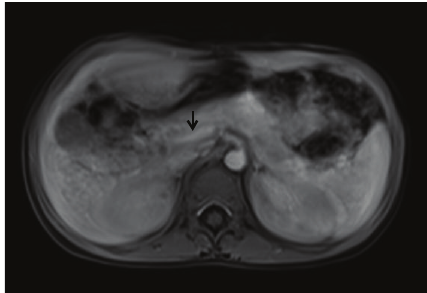
Figure 10: A 9-year-old boy with bleeding per rectum since he was 1 year old. Axial contrast enhanced MR image indicates hypoplastic main portal vein